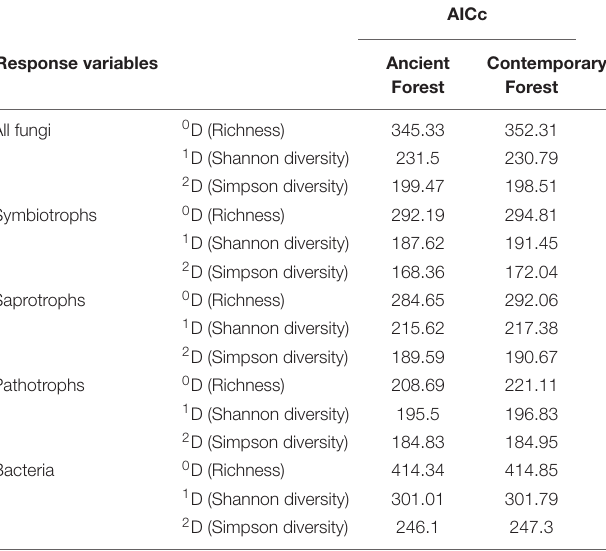
TABLE 4 | Models comparisons, with AICc, when using either ancient or contemporary forest cover as habitat amount.